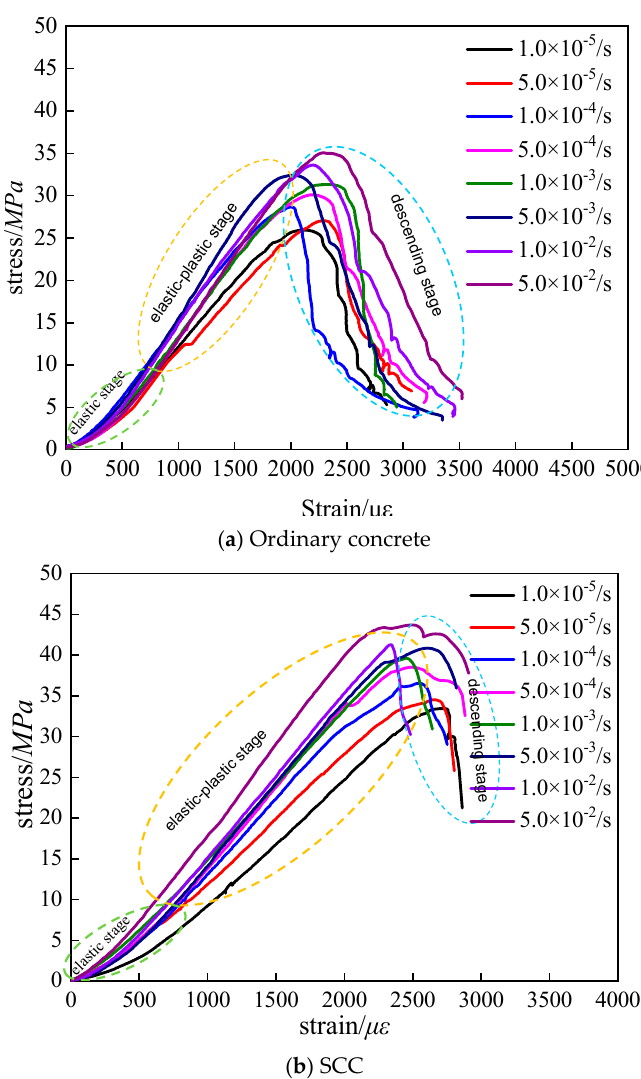
Figure 5. Stress–strain curve of concrete under uniaxial compression with different loading strain rates.